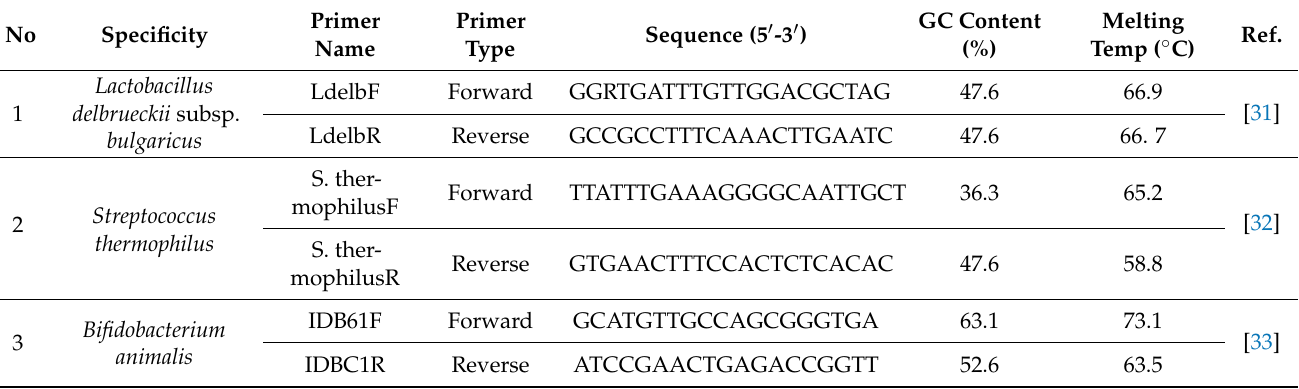
Table 1. Specific primers used for the